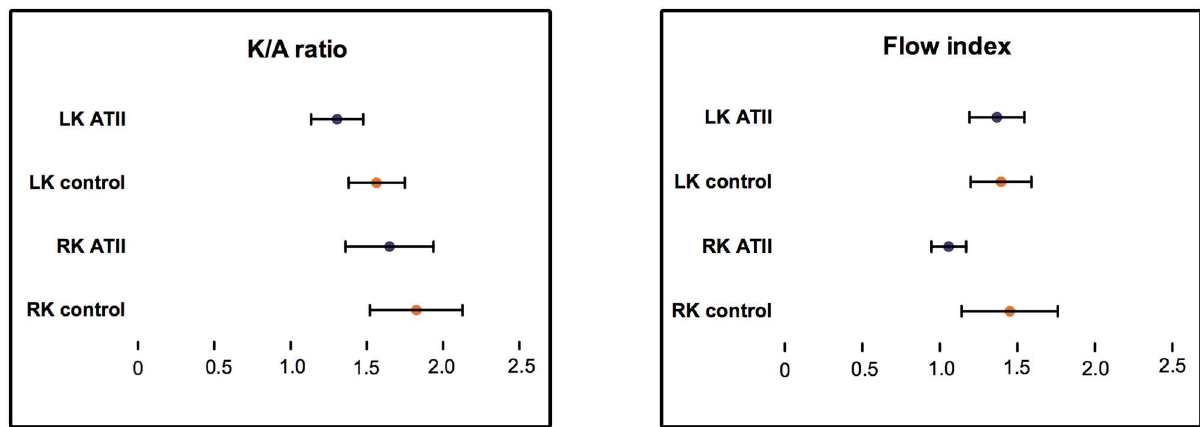
Fig 4. Changes in scintigraphic perfusion parameters induced by angiotensin II. presented as means +/- standard error. LK: left kidney, RK: right kidney.